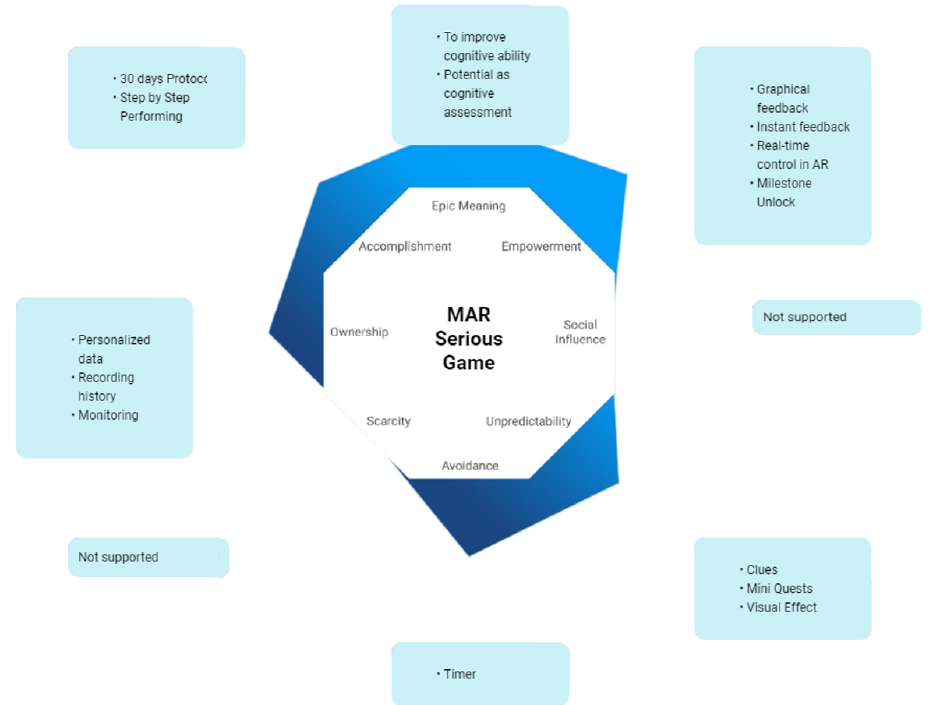
Figure 3. Average of the score provided by experts to MAR serious game using the Octalysis